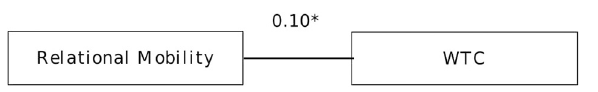
FIGURE 1 | The regression analysis results of relational mobility on WTC in English. * p < 0 .